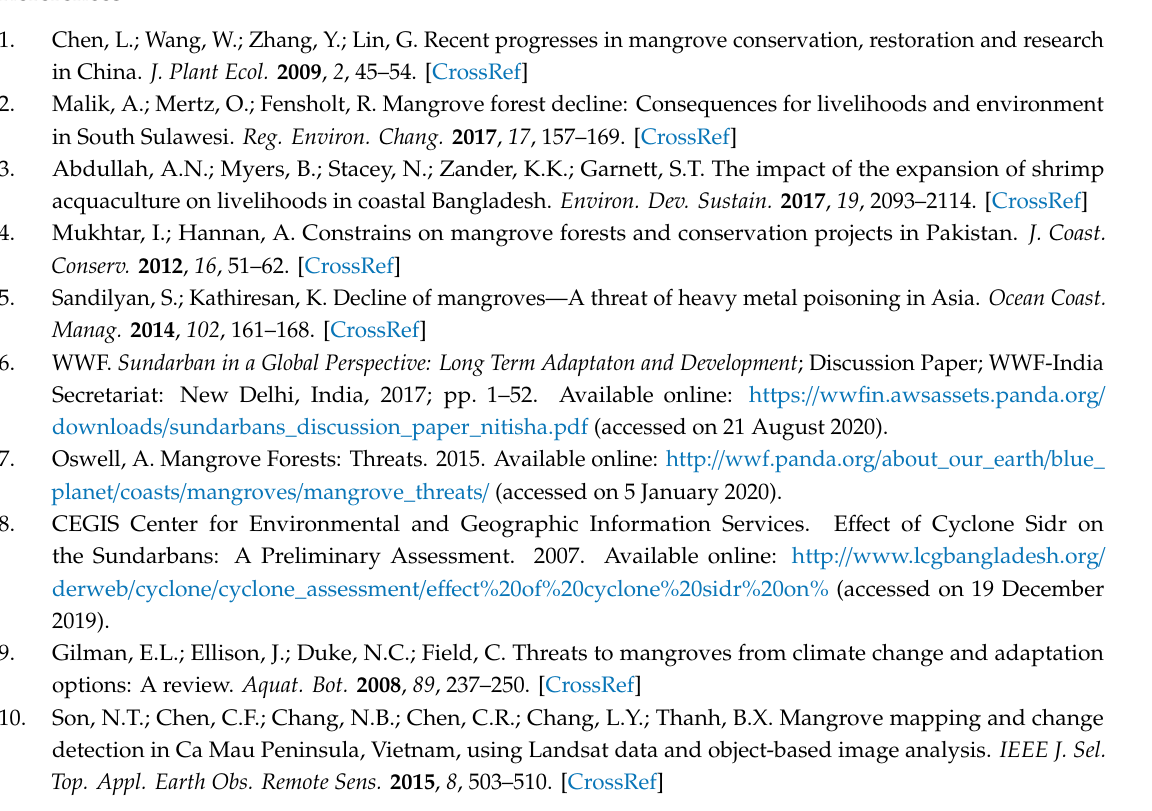
Table S1: Details of data used in this study; Table S2: Classification accuracy matrix and accuracy results for multiple classes from 2019 (simulated) to 1989: (a–f) derived based on maximum likelihood classifier (MLC) of the multi-temporal Landsat-derived classification images; Table S3: Validation of the land cover change (LCC) prediction based on the actual and simulated 2019 LC images; Table S4: Results of validation (agreement / disagreement components values) of two images and accuracy assessment of simulated LC images of 2019; Table S5: Gain / loss (%) estimation between di ff erent time periods and projected times based on LC area coverage (%) in 1989–2019 and FULC total area coverage (%) in 2019–2029. Table S6: Per year rate of change (%) calculation of LC classes between di ff erent times; Table S7: TAM of LC change assessment of the SRF based on time frame data (1989 to 2019); Table S8: Markov chain TPM of FULC classes for the period 2019-2029 by percentage; Table S9: LC change transformation of the SRF based on time frame data (1989 to 2029) (unit in ha); and Figure S1: Comparison of simulated Vs actual 2019 LC classes; Figure S2: FCC visualization specially TR to HE conversion in di ff erent time